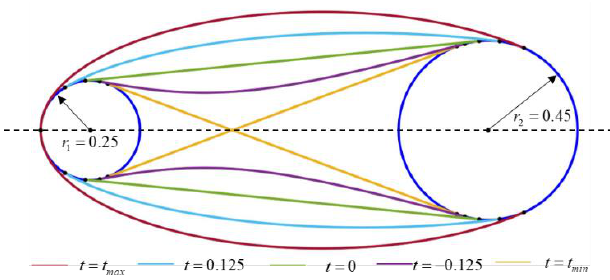
Figure 11. The strut shapes controlled by the offset parameter t .